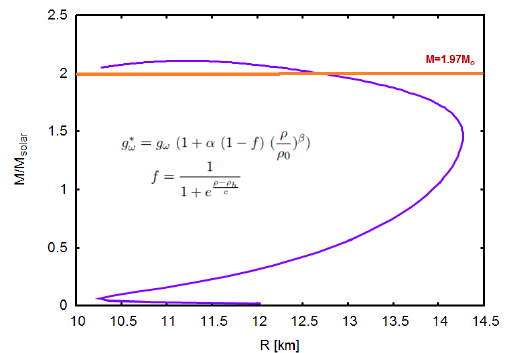
Figure 7. (Color online) Neutron star mass-radius relation by solving the TOV equations with density dependent hyperon- vector meson coupling constants, confining hyperons to a shell R 1 < r < R 2